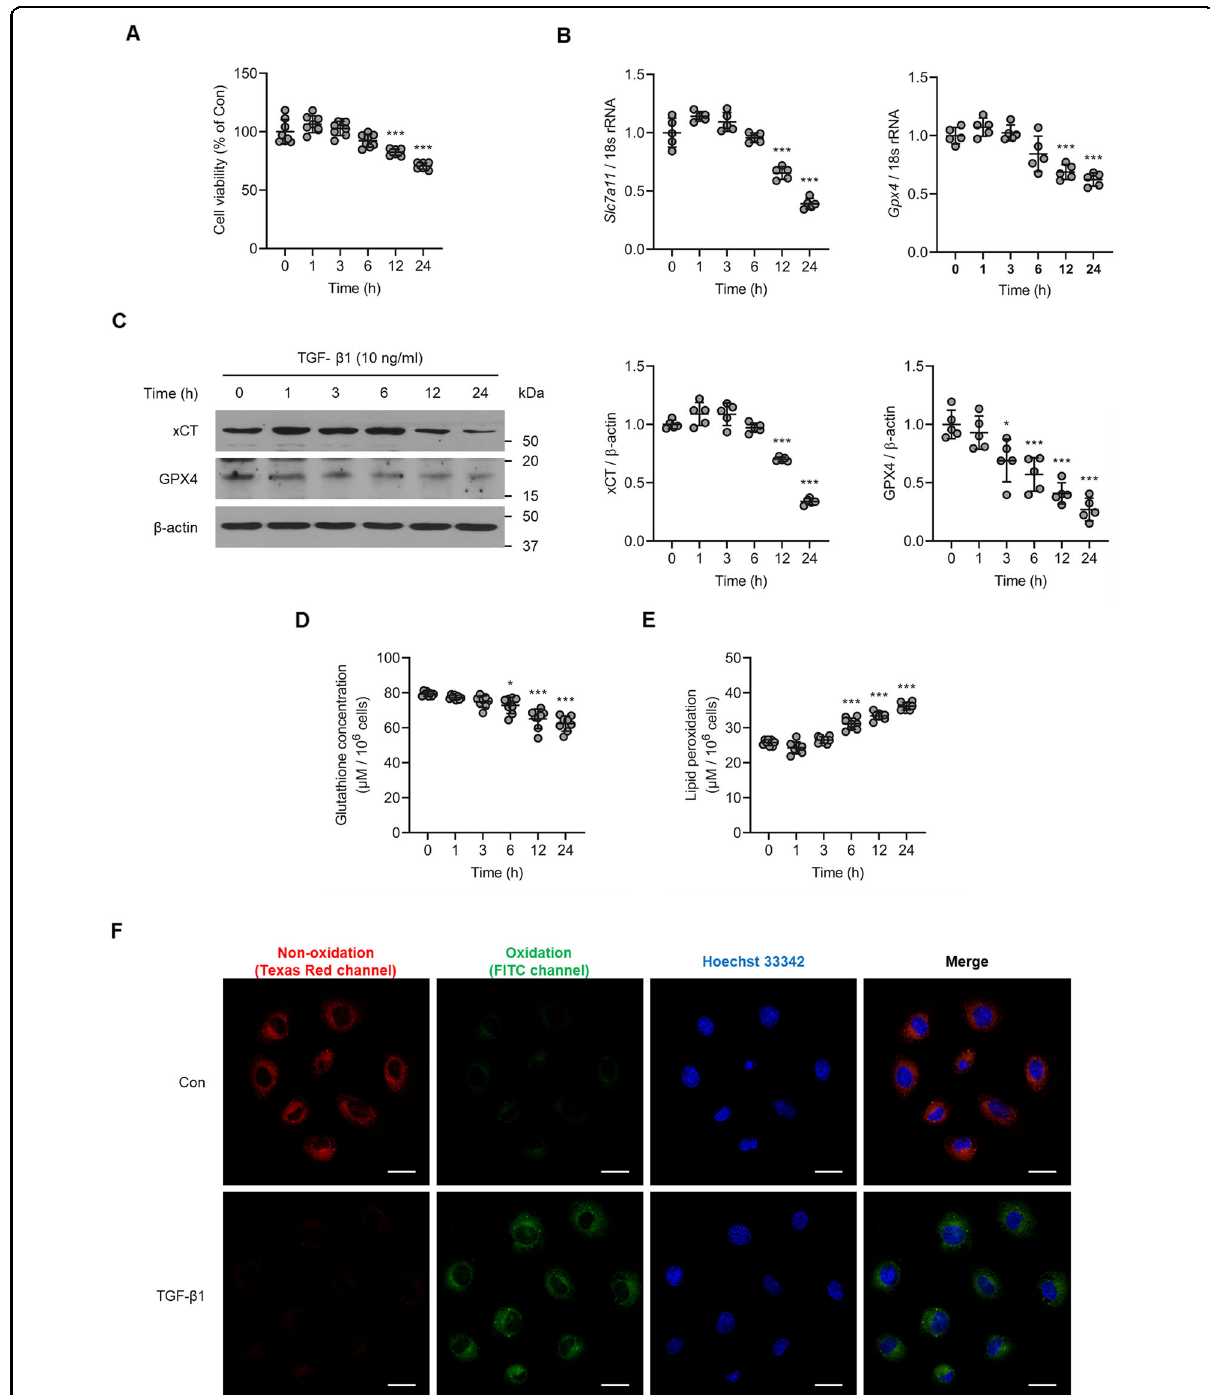
Fig. 2 TGF- β 1 induces kidney tubular cell death along with changes in ferroptosis-related molecules. A Cell viability measured via an MTT assay revealed a signi fi cant increase in the death of cultured NRK-52E cells exposed to TGF- β 1 (10 ng/ml) in a time-dependent manner. B TGF- β 1 caused a marked decrease in mRNA expression of ferroptosis-related molecules Slc7a11 and Gpx4 in NRK-52E cells. C Expression of xCT and GPX4 protein was signi fi cantly decreased in TGF- β 1-stimulated NRK-52E cells compared to control cells. D Glutathione concentration was signi fi cantly decreased in cultured NRK-52E cells exposed TGF- β 1 (10 ng/ml) after 6, 12, and 24 h. E TGF- β 1 signi fi cantly induced lipid peroxidation in NRK-52E cells after 6, 12, and 24 h. F Lipid peroxidation assessed using image-iT ® revealed an increase in TGF- β 1-treated NRK-52E cells after 12 h. As shown is representative of three independent replicates. One-way ANOVA and Bonferroni post hoc tests were used for statistical analysis. Error bars represent SD. Original magni fi cation, ×40 for all. Scale bar = 20 µm. * P < 0.05; *** P < 0.001 versus 0 h